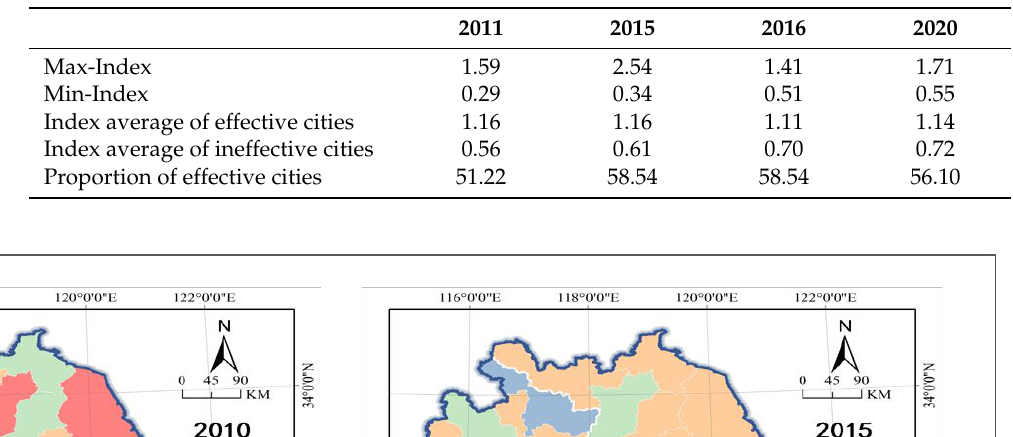
Table 4. The pure technical efficiency index of real estate inventory in the Yangtze River Delta.